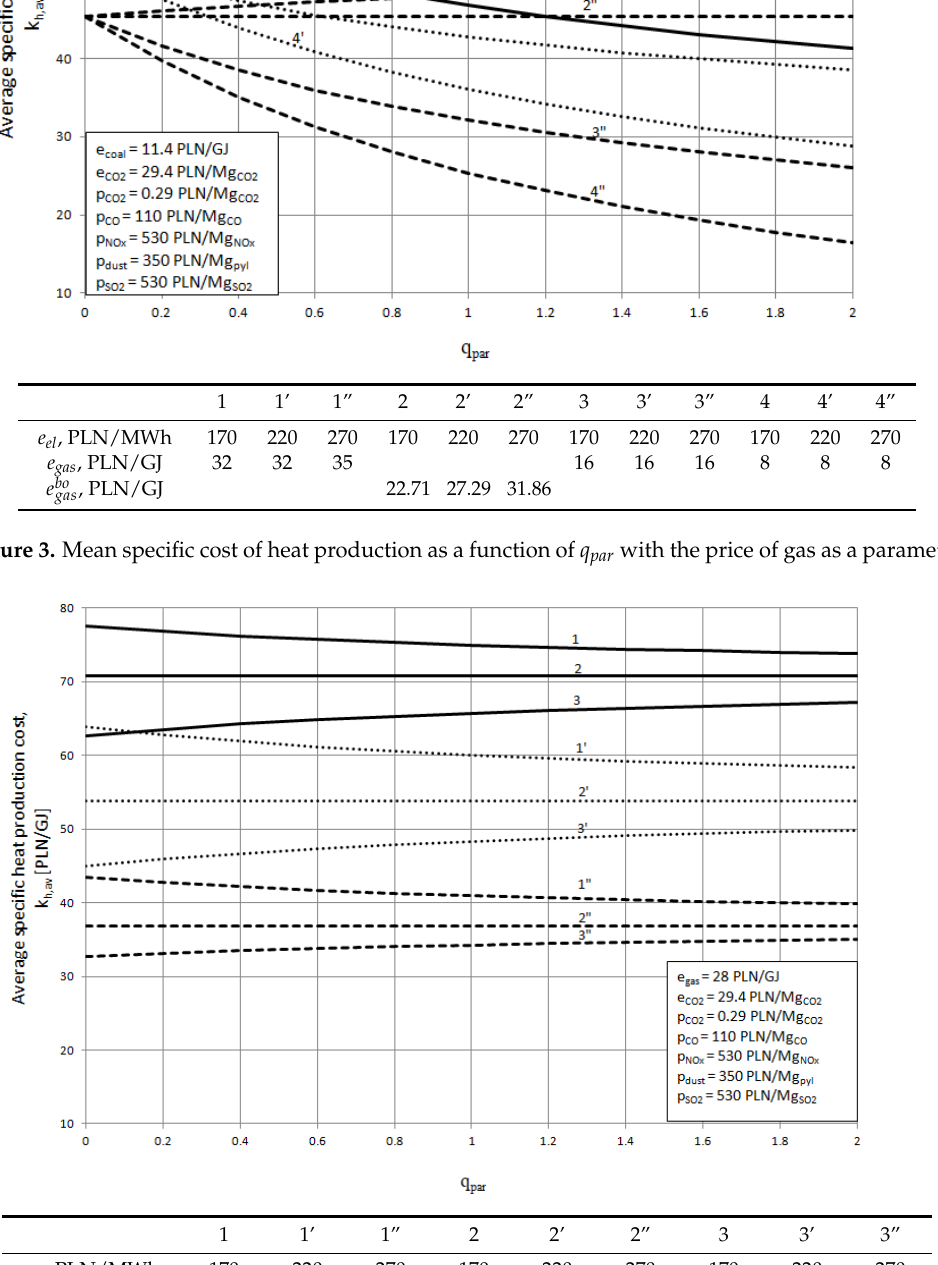
Figure 4. Mean specific cost of heat production as a function of q par with the price of coal as the parameter, where: